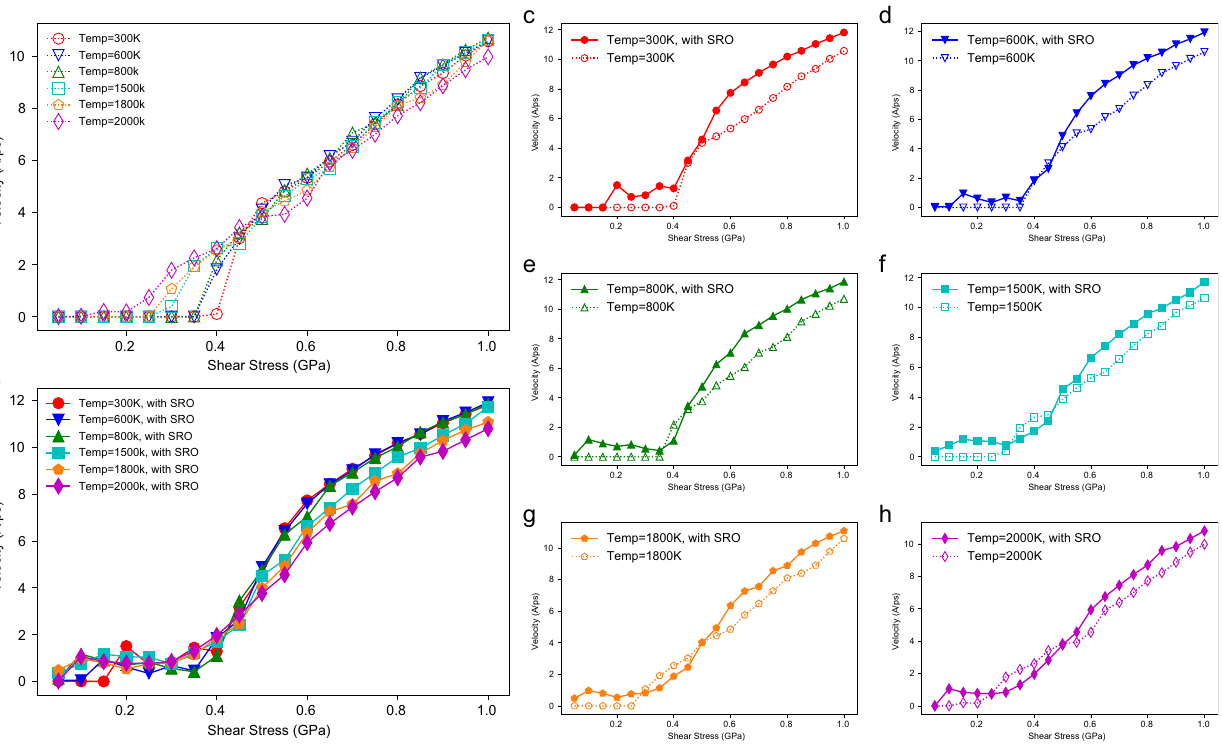
Fig. 5 The effect of SRO on the velocities of edge dislocations. a Velocity vs. stress results from the simulations of edge dislocations in the RSS sample are shown with open symbols with data for each temperature connected by dashed lines that represent guides to the eye. b Similar results as in panel ( a ), but for edge dislocations in the sample with chemical SRO. c – h Detailed comparisons of the in fl uence of SRO at representative temperatures, from 300 to 2000